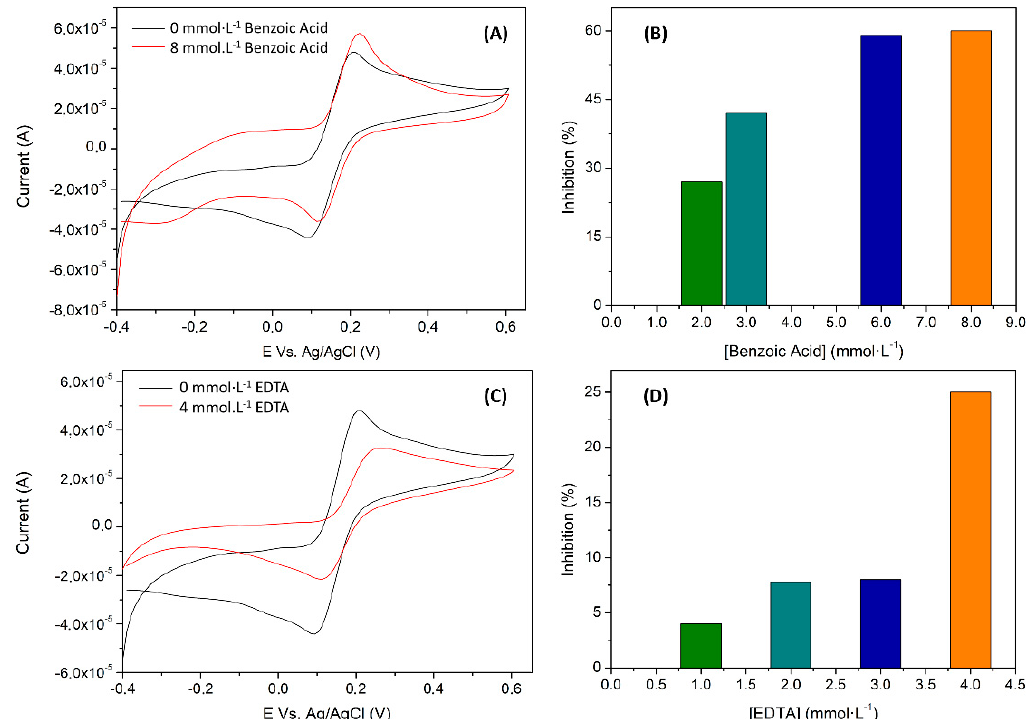
Figure 12. Biosensor inhibition study in a constant concentration of catechol (800 µmol·L − 1 ) when different concentrations of ( A , B ) benzoic acid and ( C , D ) EDTA inhibitors are present in the sample. ( A , C ) depicts the CV obtained for the maximum inhibition percentage and ( B , D ) the inhibition percentage profile when varying the inhibitor concentration. Percentage of inhibition calculated according to the relative maximum rate velocities, 100·(1 − V’/V).